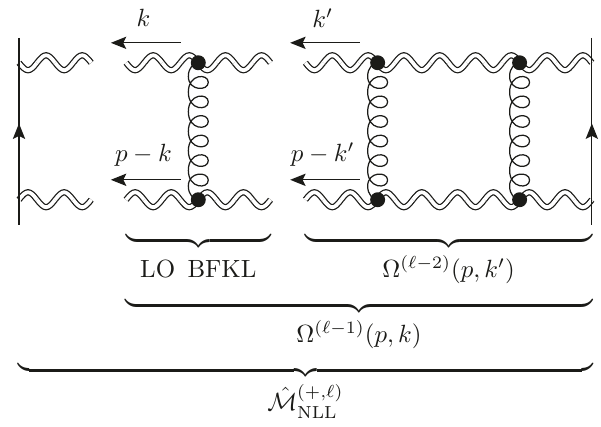
Figure 3 . Graphical representation of the amplitude at NLL accuracy, as obtained through BFKL evolution. The addition of one rung corresponds to applying once the leading-order BFKL evolution on the wavefunction of order ( ‘ 2). This gives the wavefunction at order ( ‘ 1), according to (cid:0) (cid:0) eq. (2.10). Closing the ladder and integrating over the resulting loop momentum gives the reduced amplitude, according to eq.